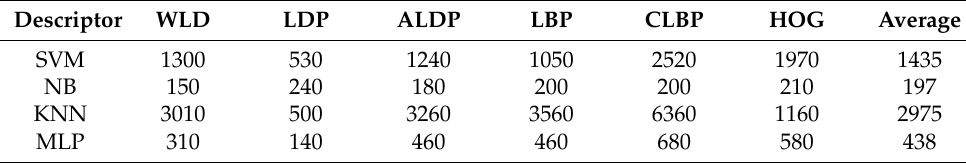
Table 6. Prediction times of various classifiers (times are given in milliseconds).